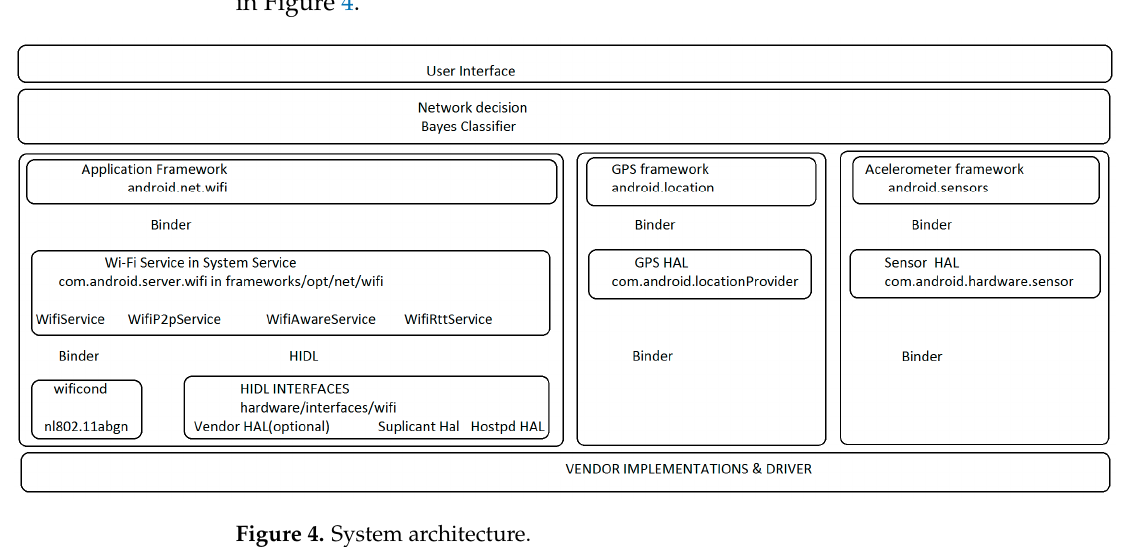
Figure 4. System architecture.